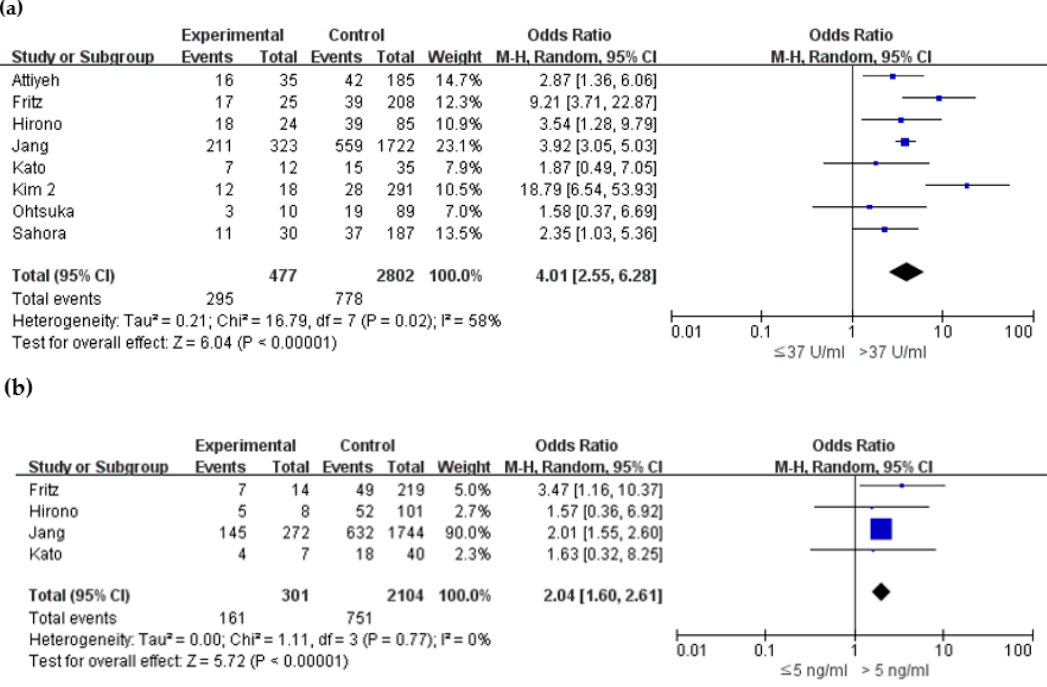
Figure 5. Forest plot demonstrates the incidence of malignancy in BD-IPMN in relation to biochemical markers. ( a ) carbohydrate antigen 19-9 and ( b ) carcinoembryonic